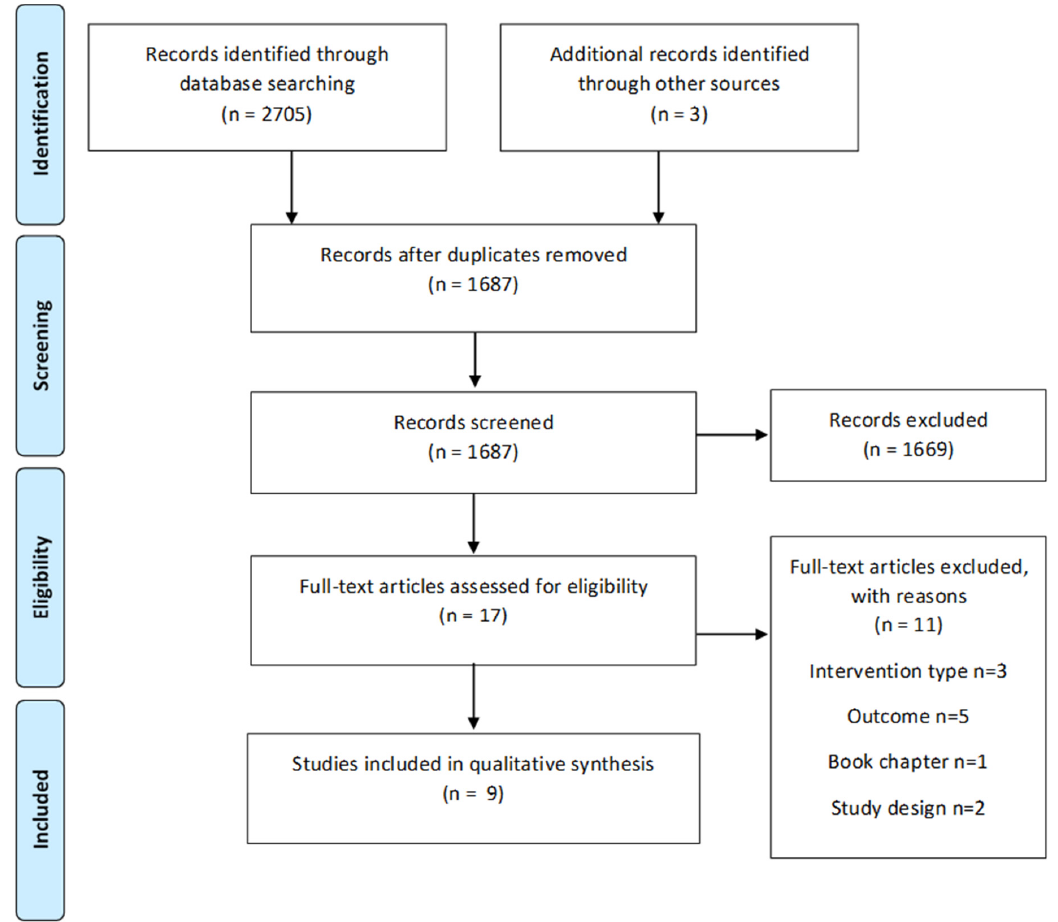
Figure 2. Study selection process.